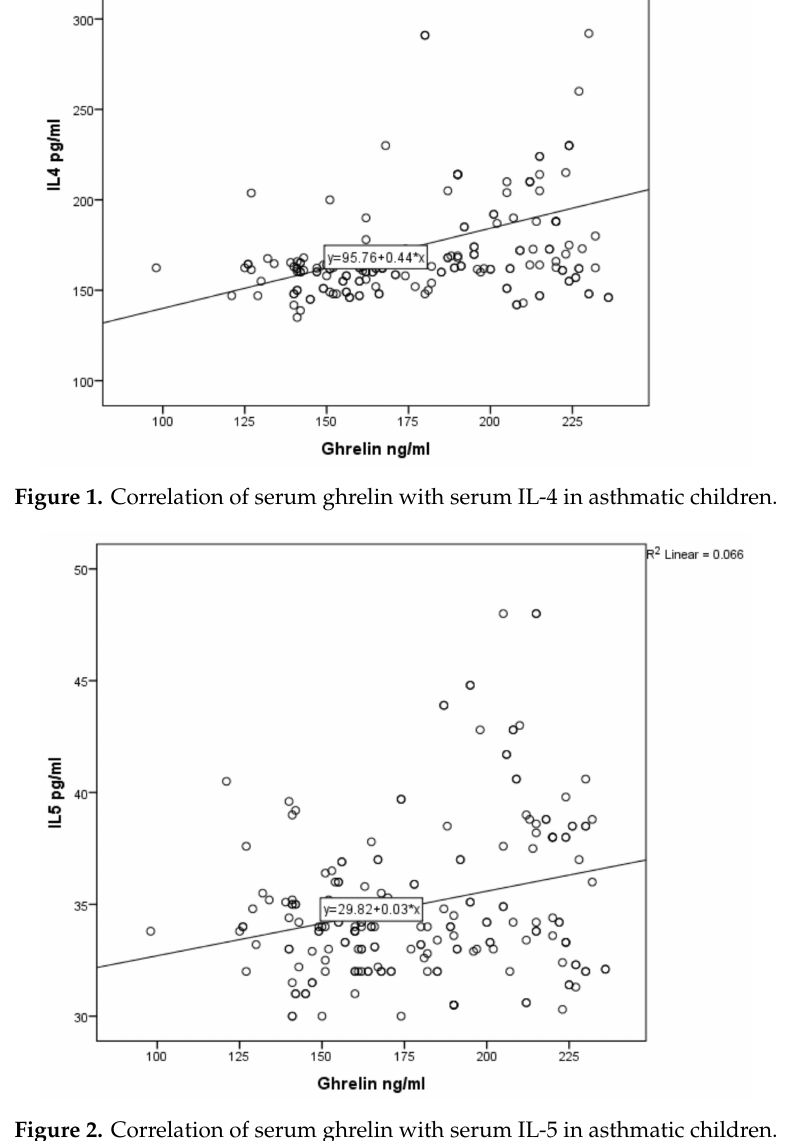
Figure 2. Correlation of serum ghrelin with serum IL-5 in asthmatic